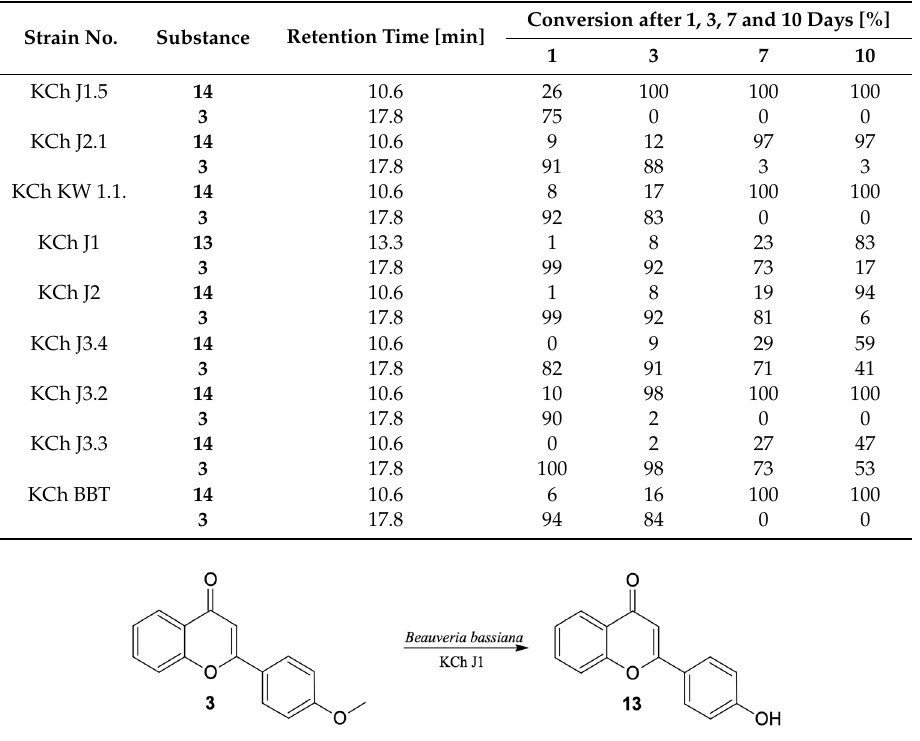
Strain No. Table 4. Microbial transformation of 4 (cid:48) -methoxyflavone ( 3 ), HPLC conversion. Strain No.